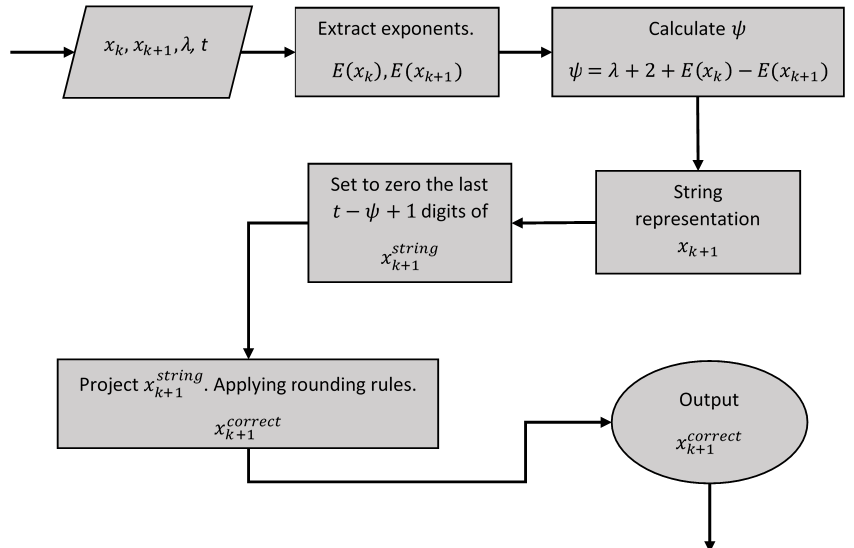
Figure 1. The flowchart of the introduced method for obtaining versions of both Bernoulli and Baker’s maps free of finite precision error; we define “correct_x( 𝑥 𝑘 ,𝑥 𝑘+1 , 𝜆, 𝑡 )” to be the procedure. In this figure-flowchart: (a) 𝑥 𝑘 , 𝑥 𝑘+1 are the values offered at the 𝑘 − 𝑡ℎ and (𝑘 + 1) − 𝑡ℎ iteration of the classical Bernoulli map, (b) 𝜆 is the number of incorrect digits appearing in the mantissa of 𝑥 𝑘 and c) 𝑡 is the necessary extension of the employed finite word length for obtaining f. p. e. free member 𝑥 𝑘+1 . The exact number of 𝑡 is 𝑛 + 2 − 𝐸(𝑥 𝑘 ) .